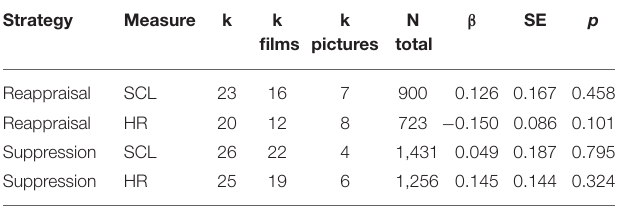
TABLE 7 | Moderator analyses on emotion induction (films vs. pictures).